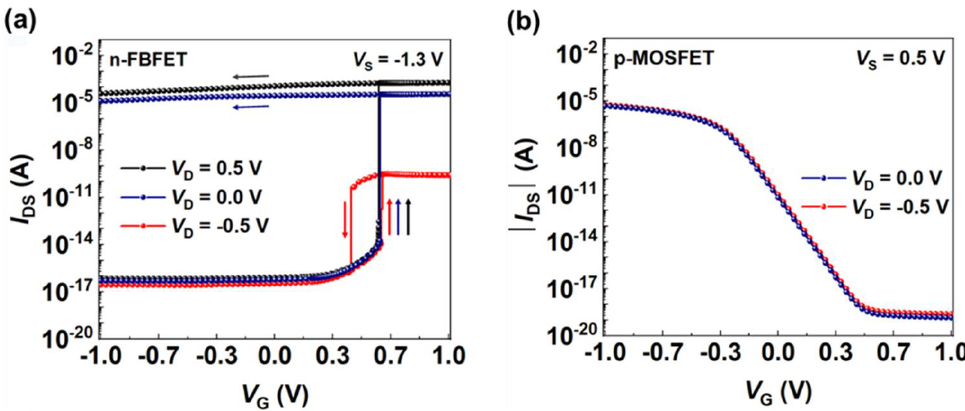
Figure 2. Simulated I DS – V G transfer characteristics of ( a ) an SiNW n-FBFET with the drain voltages ( V D ) of 0.5, 0.0, and −0.5 V under a source voltage ( V S ) of −1.3 V and ( b ) a SiNW p-MOSFET with the V D of 0.5 and 0.0 V under a V S of 0.5 V.